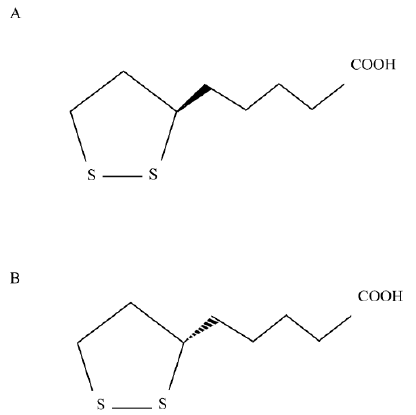
Figure 1. Chemical structure of ( A ) (+) thioctic acid and ( B ) (−) thioctic